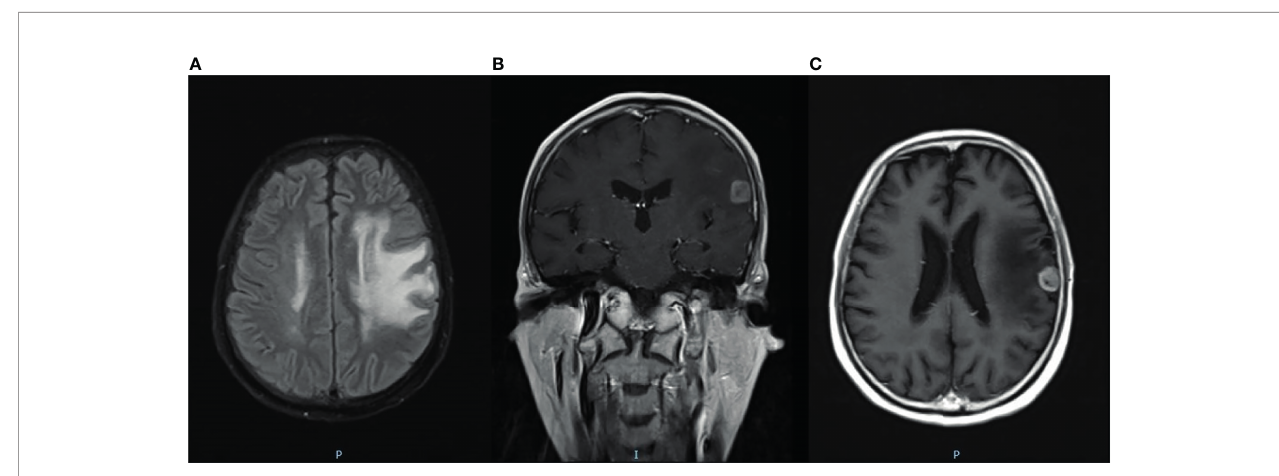
FIGURE 2 | Magnetic resonance imaging (MRI) with contrast enhancement of brain metastasis. (A – C) January 2016, before GK radiotherapy on the